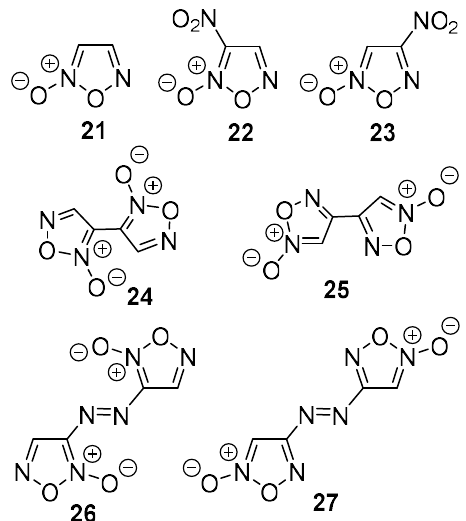
Figure 9. The parent furoxan species ( 21 ), its nitro derivatives ( 22 , 23 ), and bis- ( 24 , 25 ) and azobis bicyclic derivatives ( 26 , 27 ) considered in the thermochemical